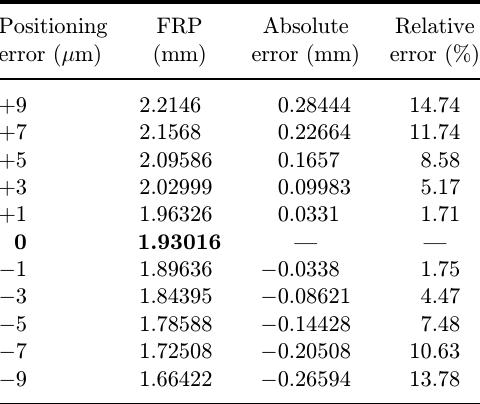
Table 6. The error caused by di®erent direction positioning